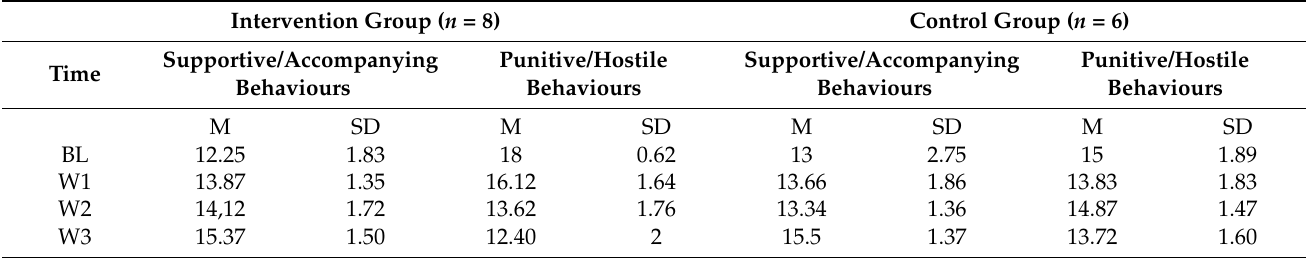
Table 7. Descriptive statistics for estimated supportive/accompanying and punitive/hostile be- haviours for both